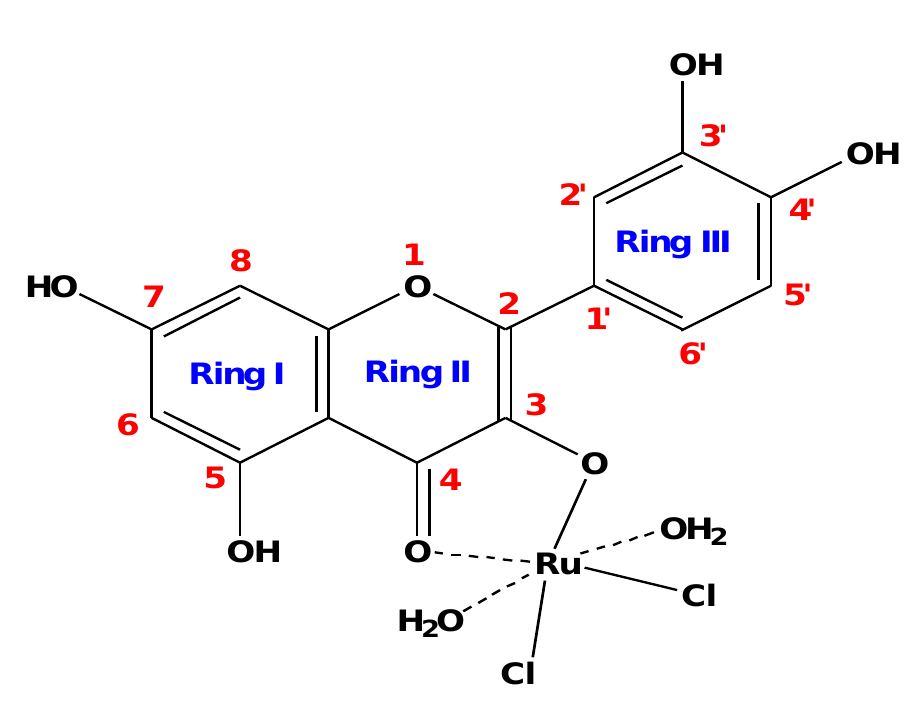
Figure 1. Suggested composition of Ru III /Q synthesized complex.